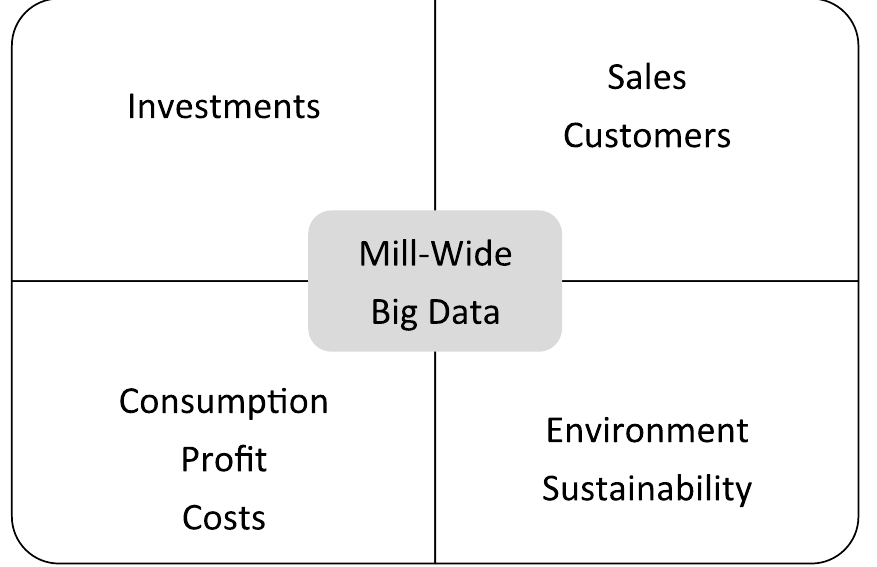
Figure 2. Connections between investments, sales, raw material mix, and consumption, manufacturing operations, environment, and sustainability.